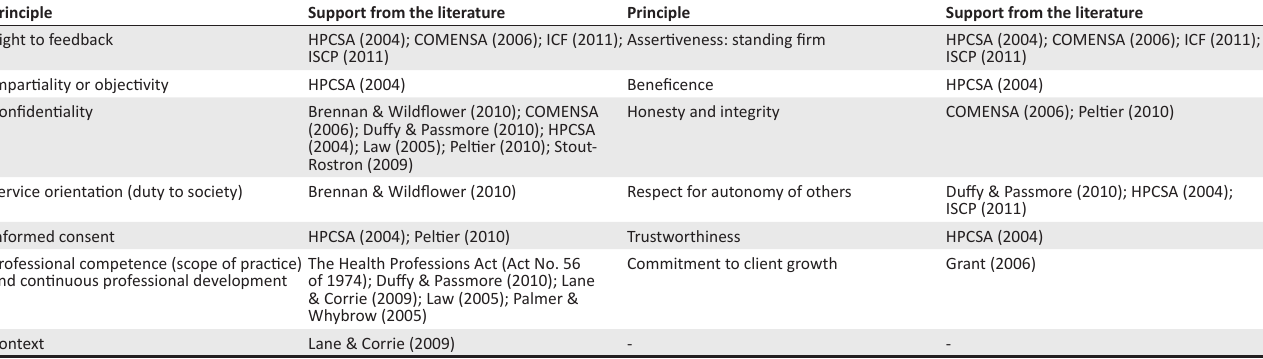
TABLE 4: Ethical principles as identified and supported by the South African coaching psychologists. Principle